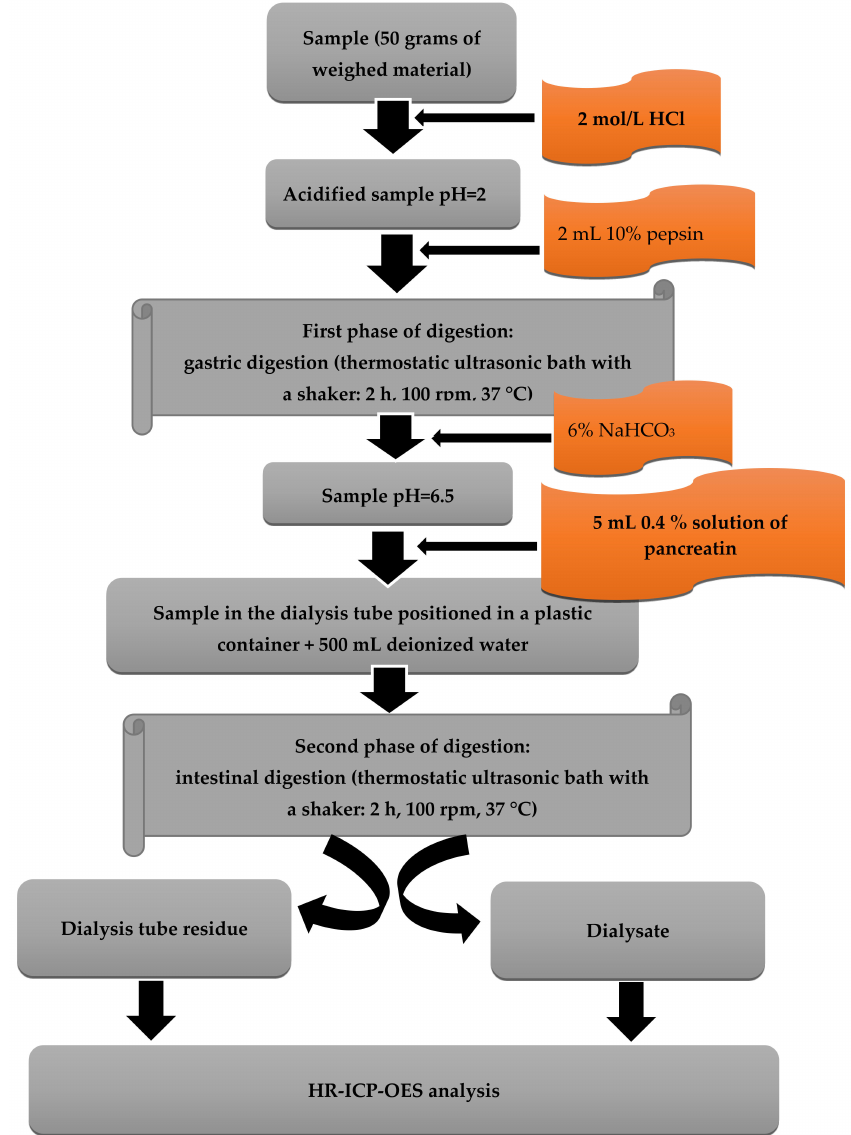
Figure 1. Schematic illustration of the digestion